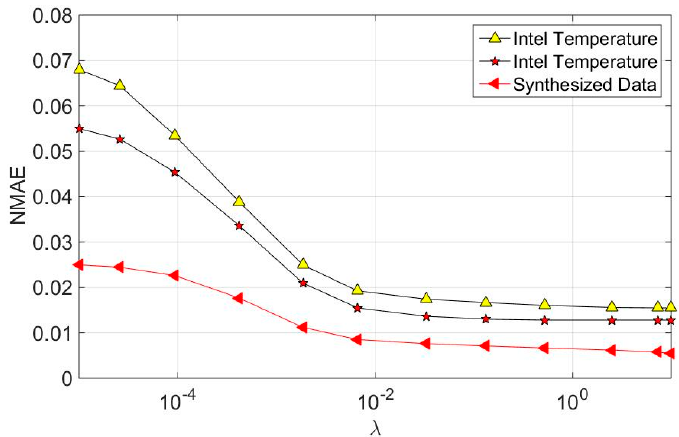
Figure 5. The effect of the sparsity regularization parameter λ .